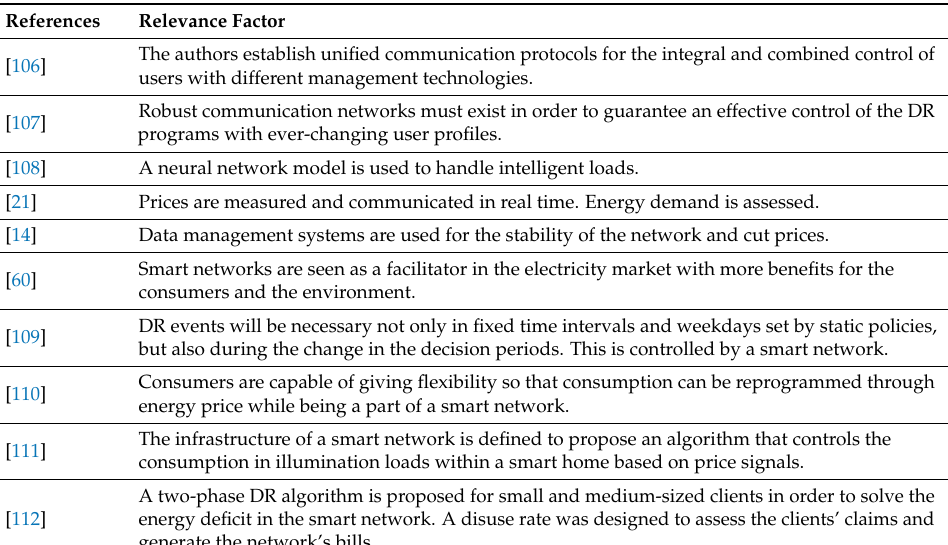
Table 5. DR and its relation with smart